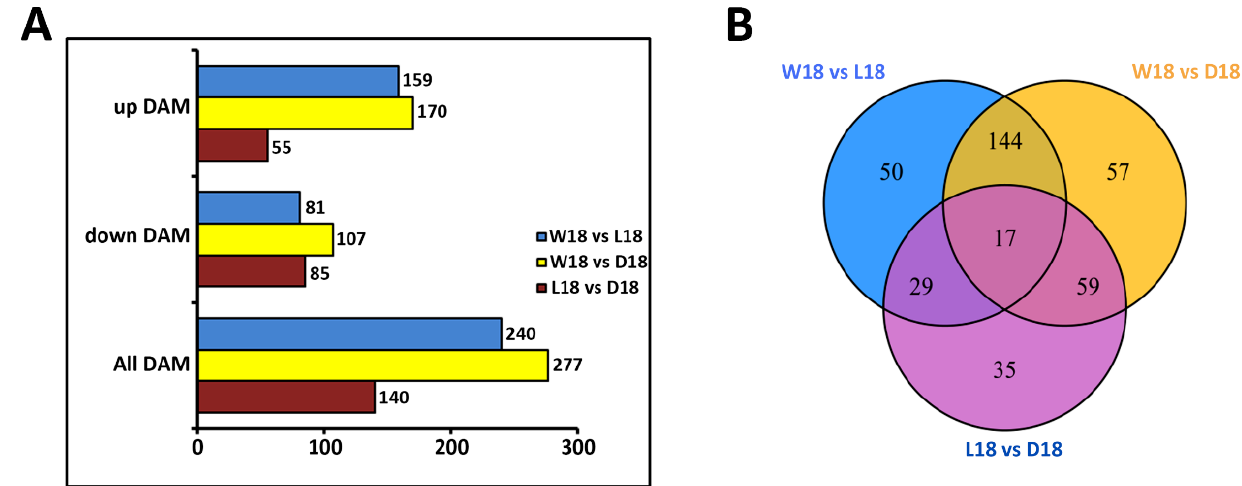
Figure 1. Differentially expressed metabolites analysis. ( A ) Bar chart of metabolite expression levels in D18, L18, and W18. ( B ) Venn diagram showing different metabolites identified between WCF, LCF, and DCF. L18, D18, and W18 represent deep brown fiber, light brown fiber, and white fiber at 18 DPA.